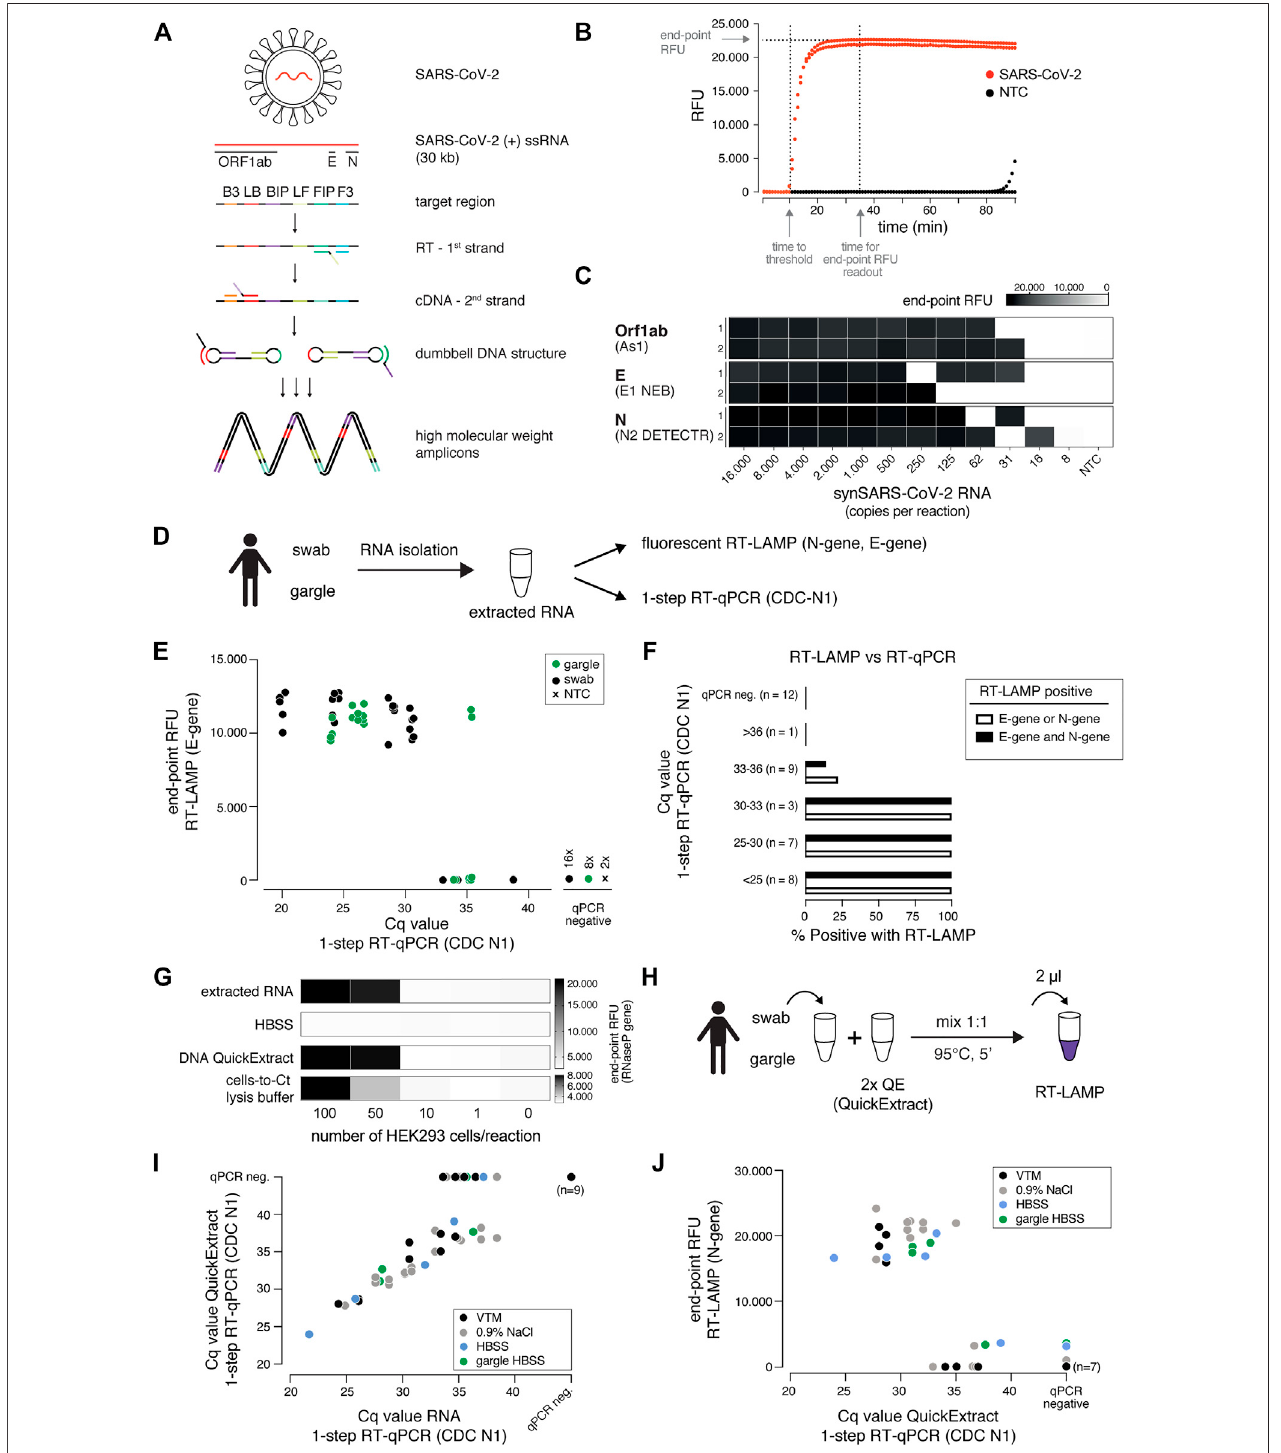
FIGURE 1 | A sensitive, robust RT-LAMP assay compatible with crude patient samples. (A) Schematic illustrating loop-mediated ampli fi cation (LAMP) of SARS- CoV-2RNAandtheregionstargetedinthisstudy(Orf1ab,EandNgenes;depictedabove).Eachtargetregionisrecognizedbyade fi nedsetofprimers(B3,LB,BIP,LF, FIP,F3).TheRNAtemplate(red)isreversetranscribedanddisplacedafter fi rst-strandsynthesis;theouterprimerbindingsitesareaddedinthesubsequentampli fi cation step. Theresulting dumbbell DNA structure acts astemplate for further rounds ofampli fi cation, ultimately leadingtohigh molecular weight amplicons. (B) Readout of a real-time fl uorescence RT-LAMP reaction using 500 copies of synthetic SARS-CoV-2 (red) or water as non-targeting control (NTC, black) as input. “ Time